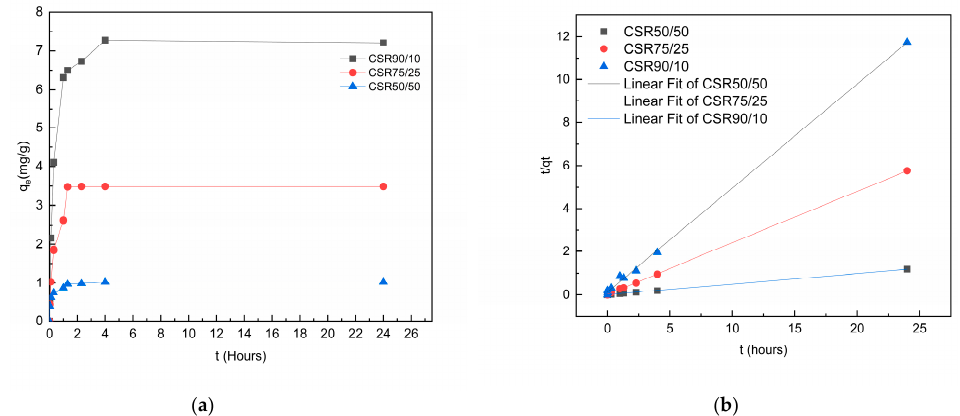
Figure 4. Kinetic study of CS/R aerogels in combination with initial concentrations ( a ) Influence of adsorption time on Cr (VI) removal with 25 mg/L as initial concentration; ( b ) pseudo-second-order kinetic model of Cr (VI) adsorption with 100 mg/L as initial concentration.